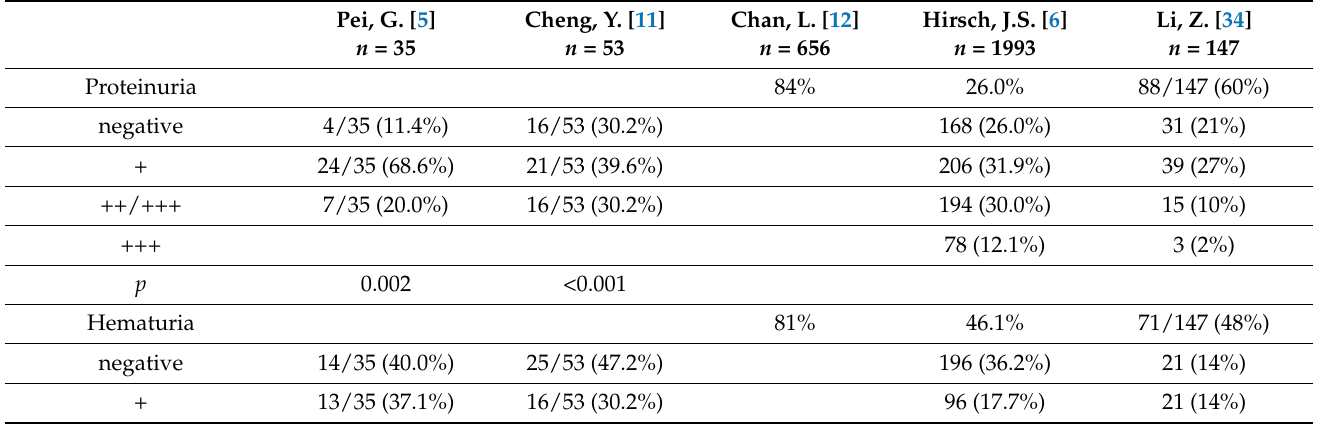
Table 3. Laboratory data in AKI patients with